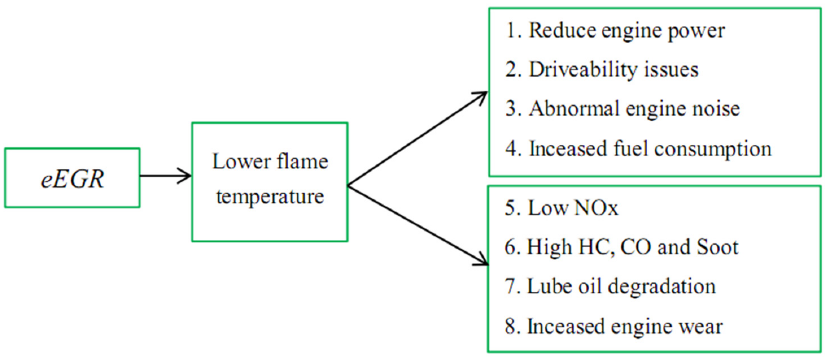
Figure 1. The effects of eEGR on diesel engine performance and emission characteristics.